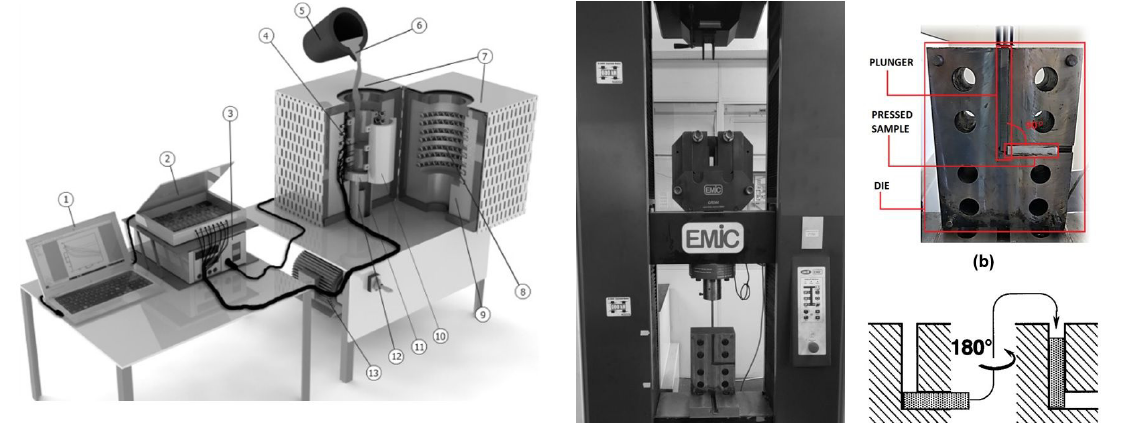
Figure 2. Diagrammatic representation of equipment: (1) personal computer and data-acquisition software; (2) data-logging hardware; (3) temperature-control system; (4) K thermocouples; (5) crucible; (6) melt; (7) unidirectional solidification furnace; (8) electric heaters; (9) ceramic fiber insulation; (10) steel mold; (11) steel plate; (12) water-cooled bottom; (13) water pump (Ferreira et al. 27 ).